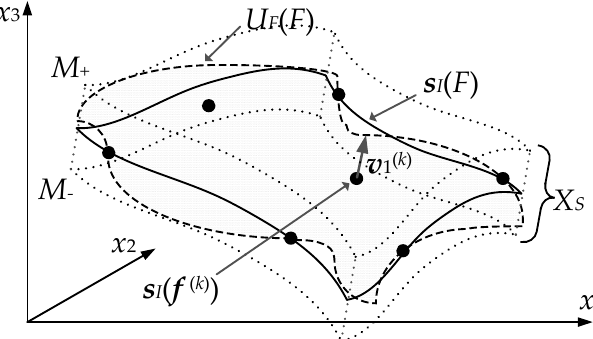
Figure 2. The image s I ( F ) of the first-level surrogate model and the normal vector v 1( k ) at f ( k ) ; the manifolds M – and M + and the surrogate model domain X S defined as the orthogonal extension of s I ( F